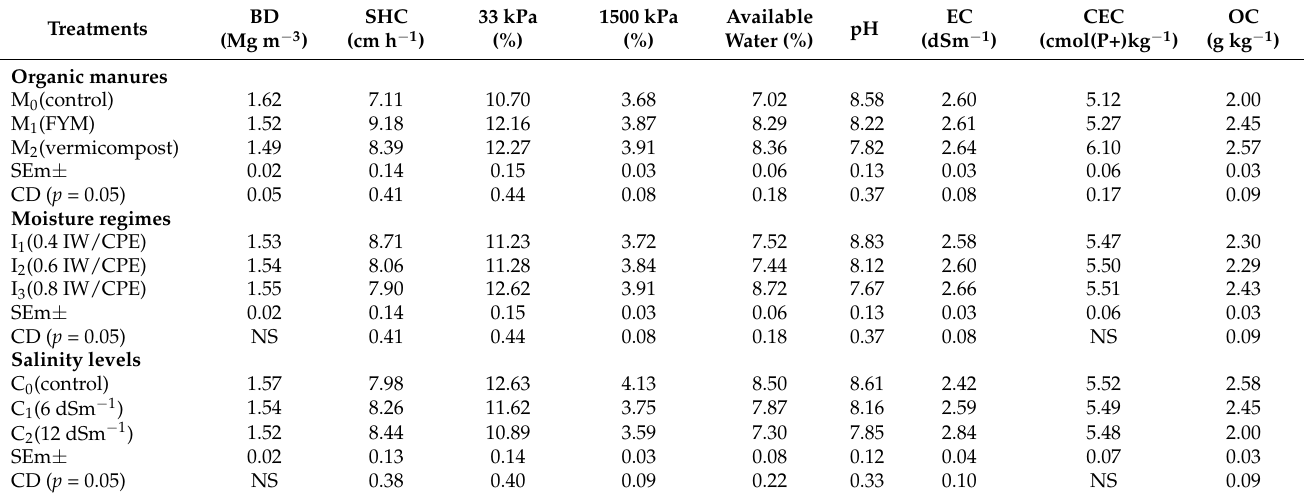
Table 1. Effect of organic manures and moisture regimes on physico-chemical properties of soil at harvest.